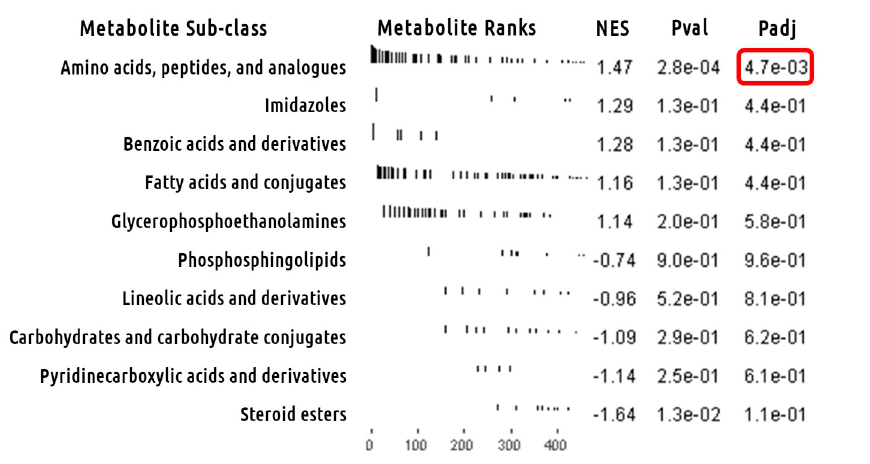
Fig 5. Heterogeneity metabolite set analysis of full model